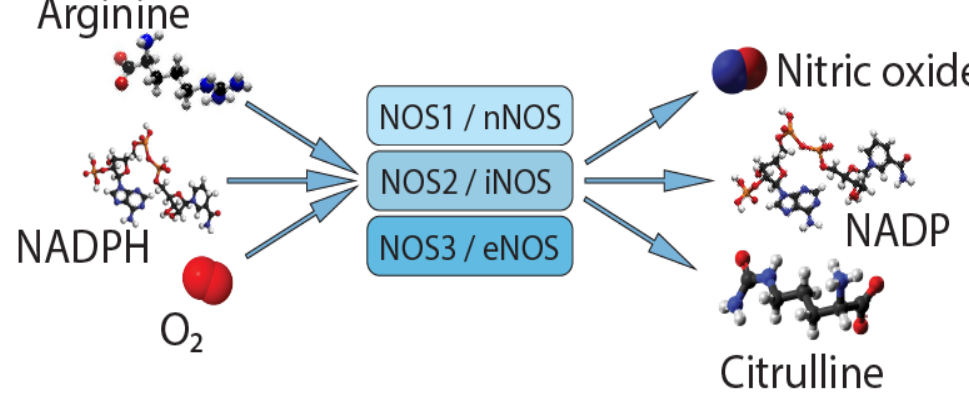
Figure 1. Synthesis of nitric oxide.